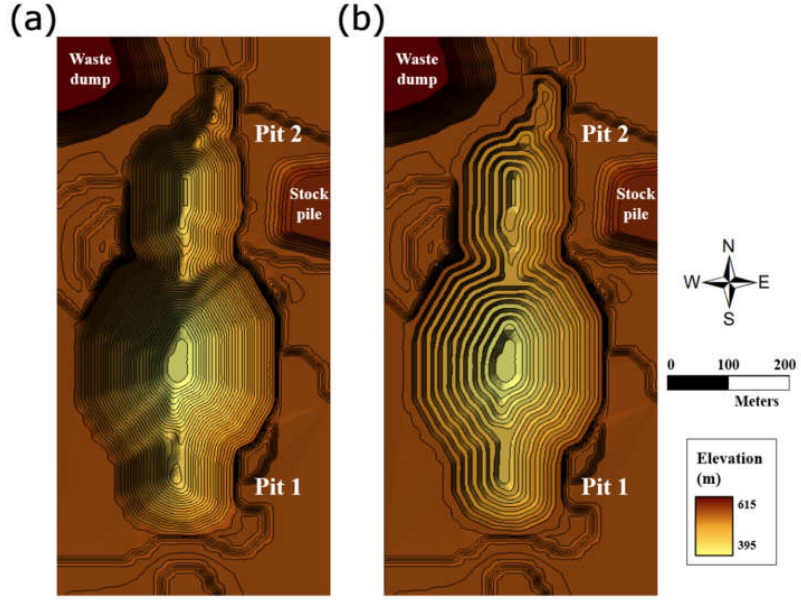
Table 2. Economic parameters and values for calculating the economic value of a block.